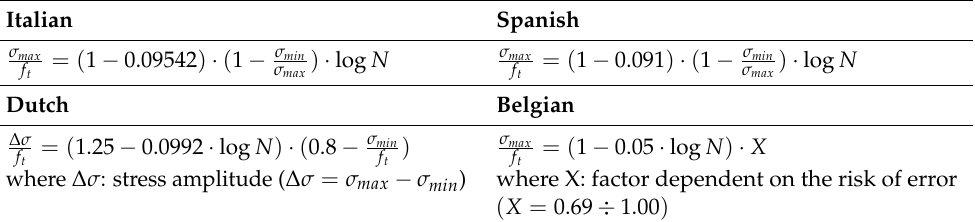
Table 9. Damage calculation according to different national annexes.